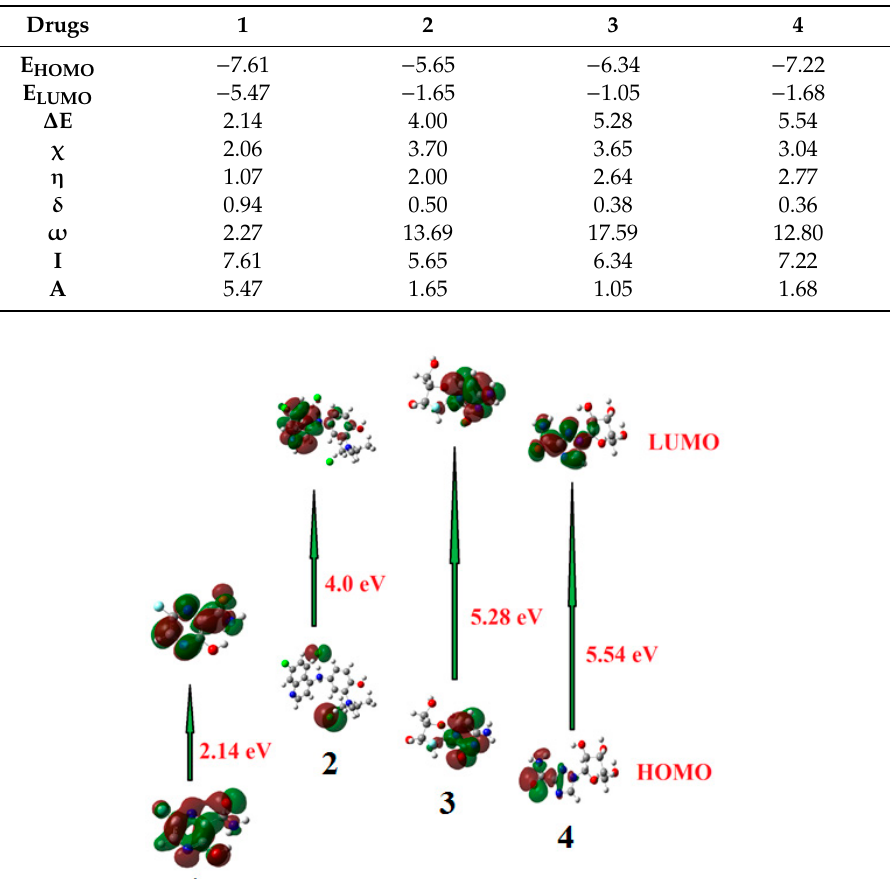
Table 2. Calculated electronegativity ( χ ), global hardness ( η ), softness ( δ ), global electrophilicity index